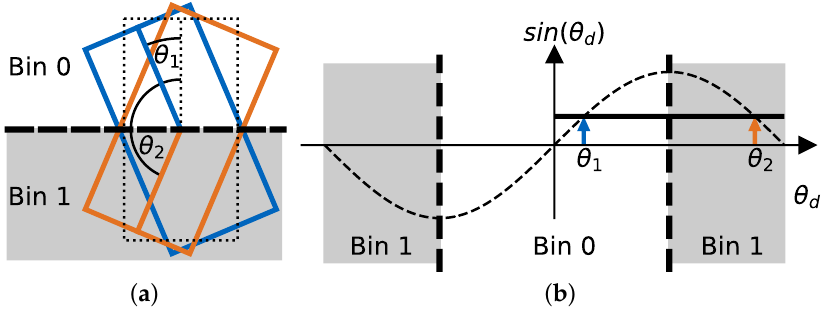
Figure 3. Visualization of our yaw loss. ( a ) Bin classification. ( b ) Sine regression. The bounding boxes in ( a ) are not distinguishable by the sine loss. The bin classification distinguishes these bounding boxes as visualized by the bold dotted line, which splits the angular space in two